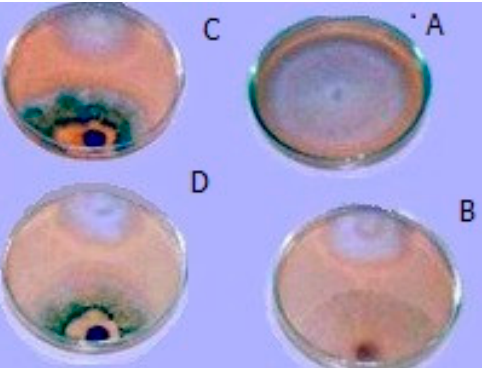
Figure 4. In vitro screening of the endophytic fungi for their biocontrol potential against the highly virulent Fusarium solani isolate. ( A ), Control; ( B ), Chaetomium globosum ; ( C ), Trichoderma harzianum ; ( D ), T . longibrachiatum .